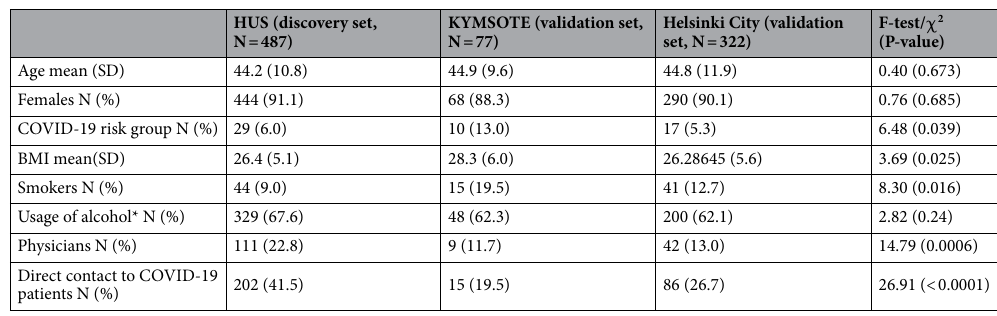
Table 1. Sociodemographic characteristics of the included datasets. *Any weekly dose of